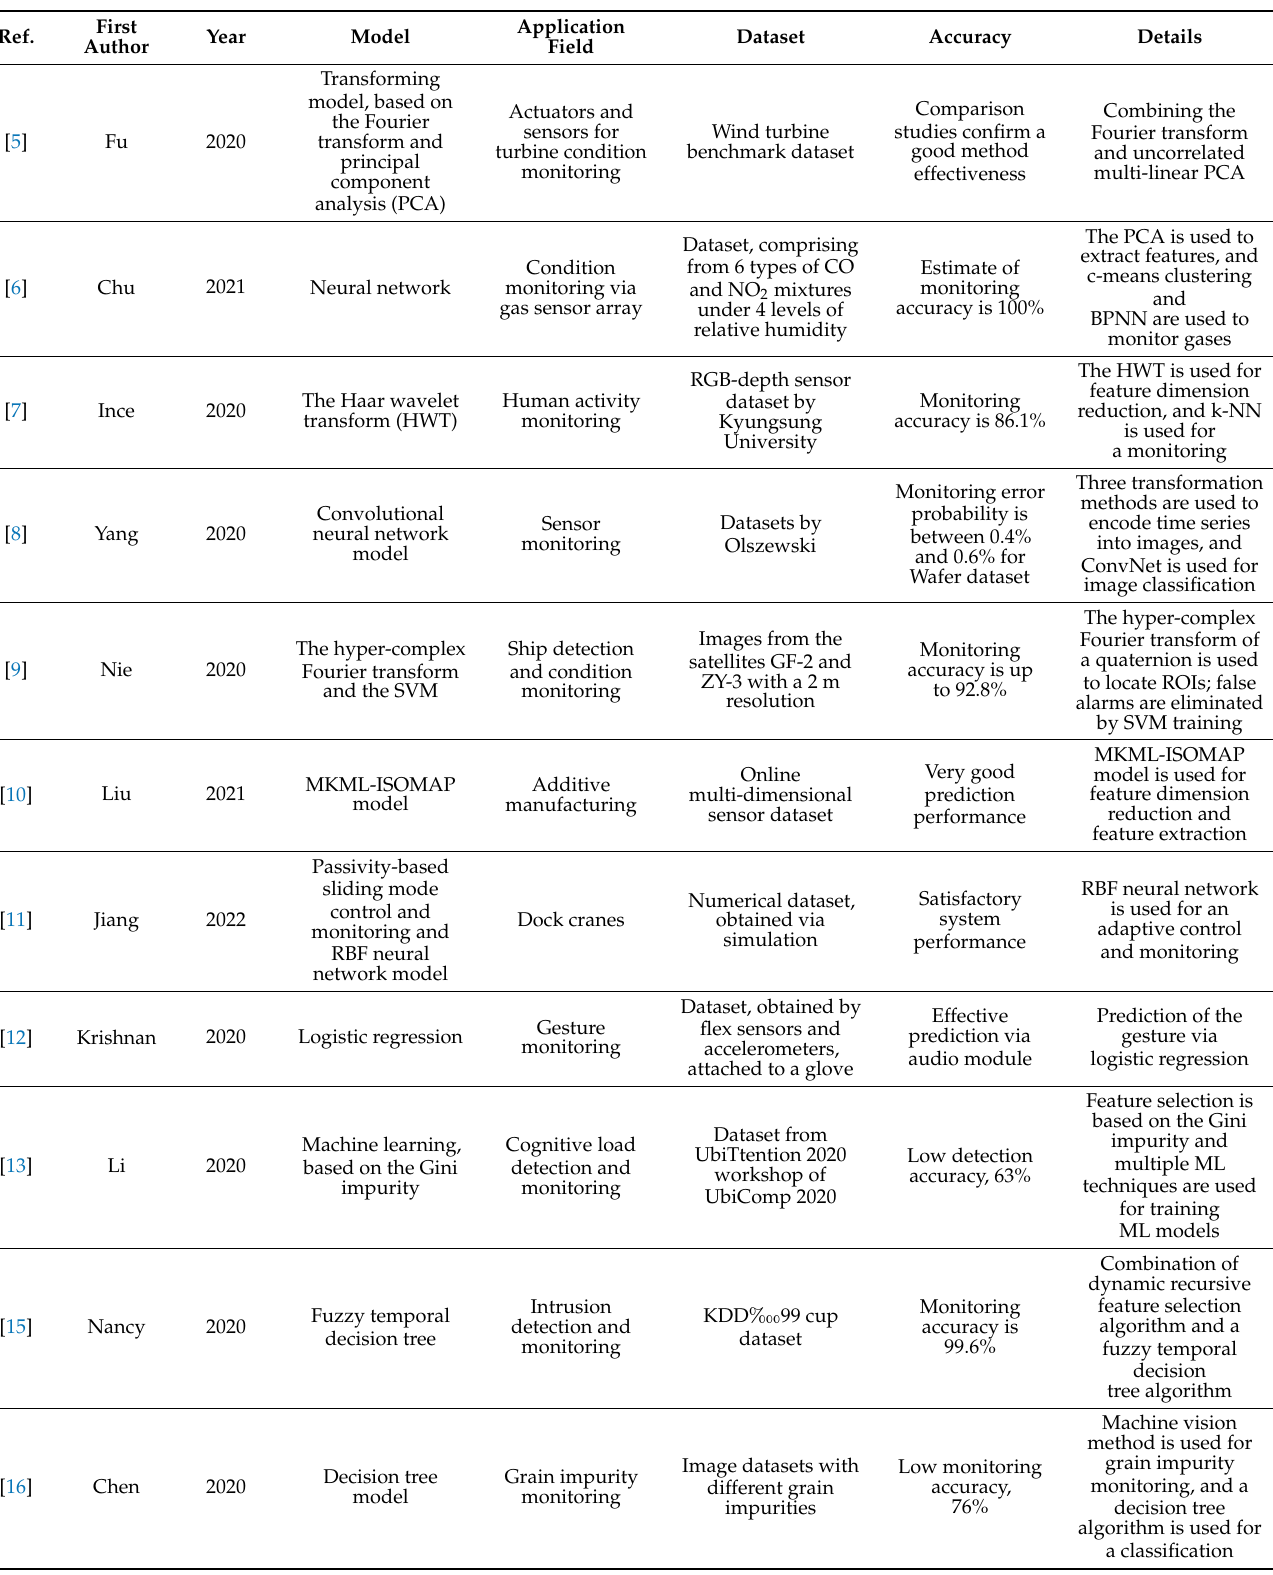
Table 1. Summary of the advances in supervised machine learning for sensing and condition